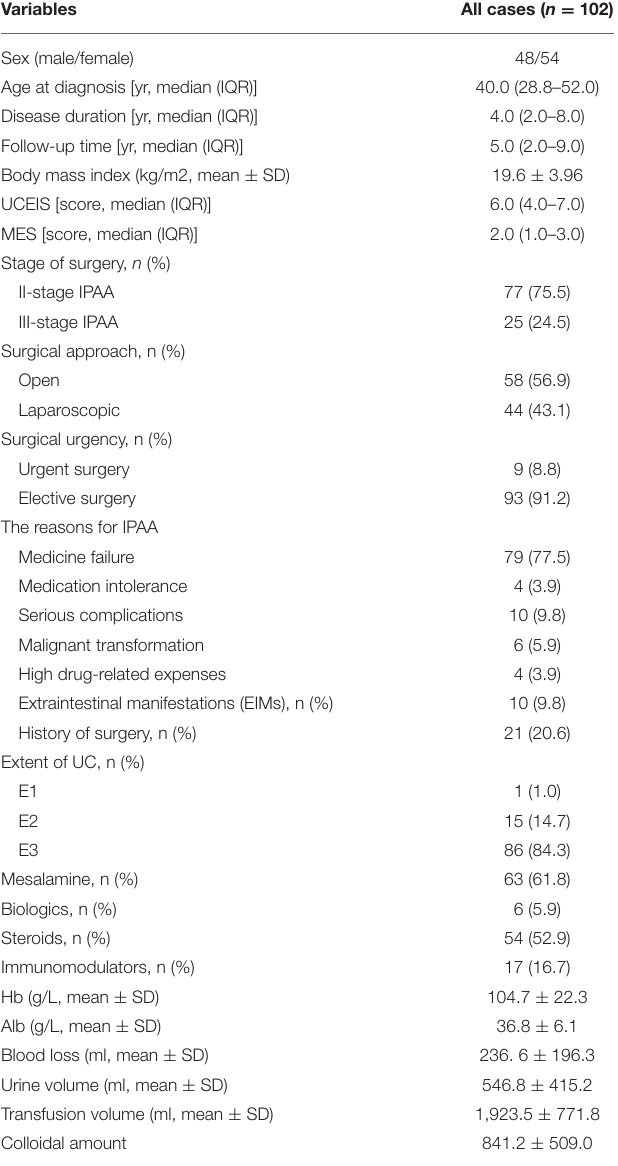
TABLE 1 | Main baseline characteristics of patients.